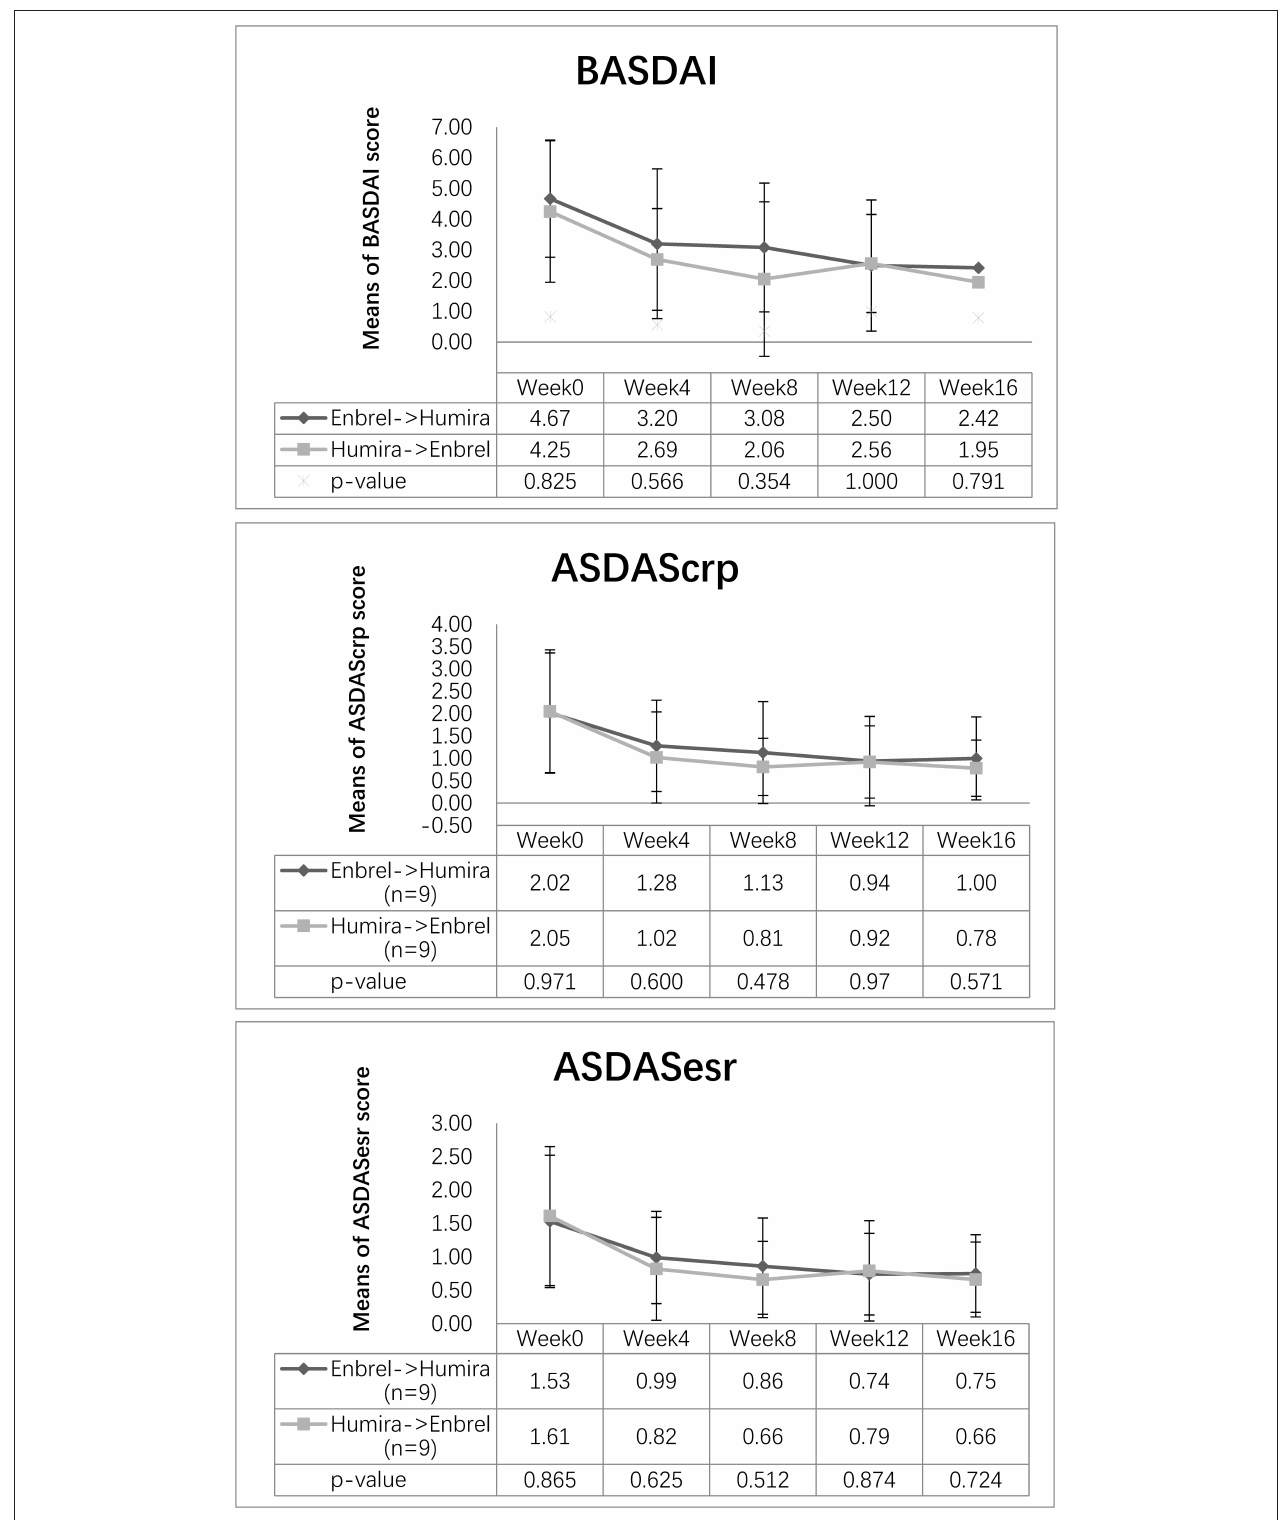
FIGURE 2 | Changes in disease activity scores for the two arms. Descending trend was noticed in BASDAI, ASDAScrp, and ASDASesr in both the treatment arm and the control arm. Outcome measurements were comparable for the three disease activity scores at weeks 8 and 16 ( p > 0.05).